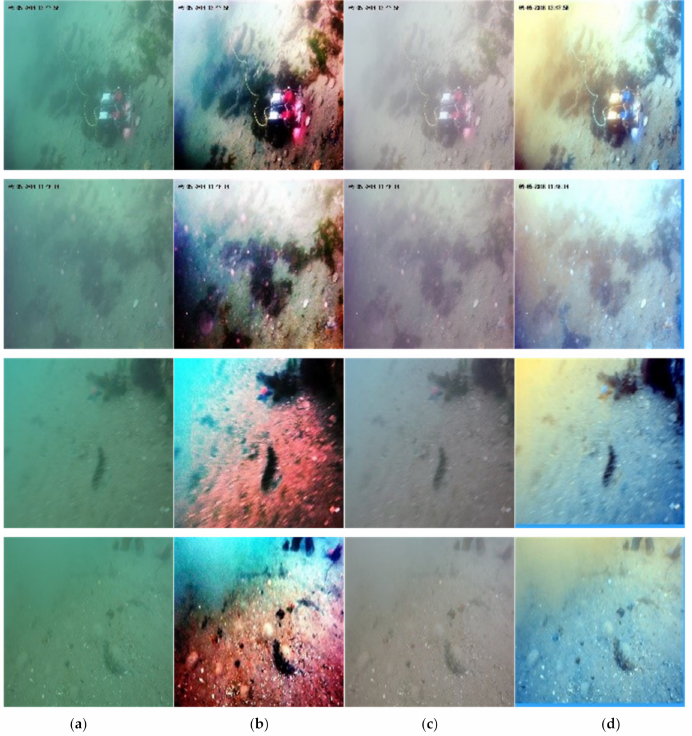
Figure 6. Color cast correction results of different methods: ( a ) original image, ( b ) histogram equalization, ( c ) ground Truth and ( d ) proposed